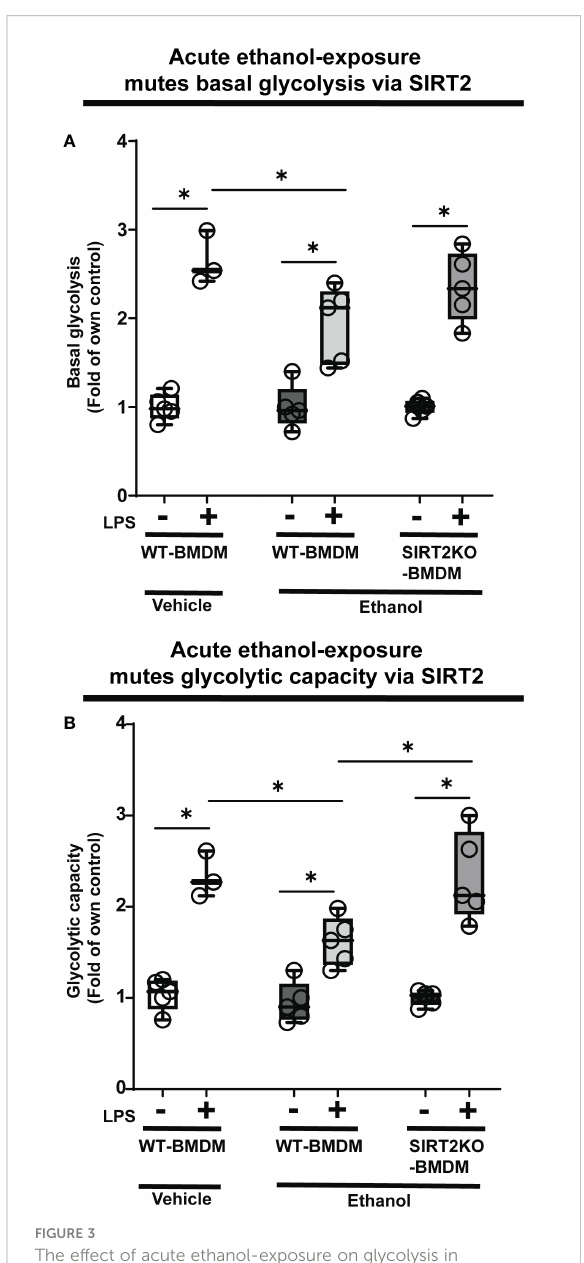
FIGURE 3 The effect of acute ethanol-exposure on glycolysis in macrophages. Glycolysis assay in BMDM exposed to vehicle or ethanol ± LPS. Y-axis represents response to LPS (+ LPS) as a fold of respective group without LPS (-LPS) represented as “ Fold of own control ” . (A) Basal glycolysis (mean ECAR after glucose addition) in Vehicle-exposed WT-BMDM, Ethanol-exposed WT- BMDM and Ethanol-exposed SIRT2KO-BMDM ± LPS stimulation. (B) Glycolytic capacity (mean ECAR upon addition of ATP synthase inhibitor oligomycin) in Vehicle-exposed WT-BMDM, Ethanol-exposed WT-BMDM and Ethanol-exposed SIRT2KO- BMDM ± LPS stimulation